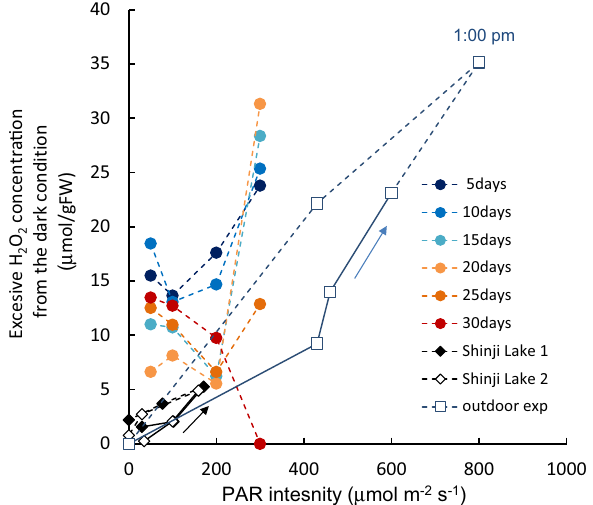
Figure 5. The H 2 O 2 increment due to the PAR intensity from the values of samples in dark condition. In Shinji Lake, and outdoor exp., straight line: morning (PAR increasing), and dashed line: afternoon (PAR decreasing).